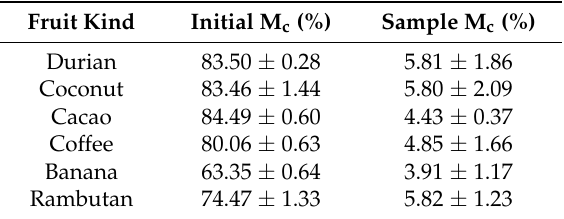
Table 4. Moisture content of investigated fruit waste biomass kinds. Fruit